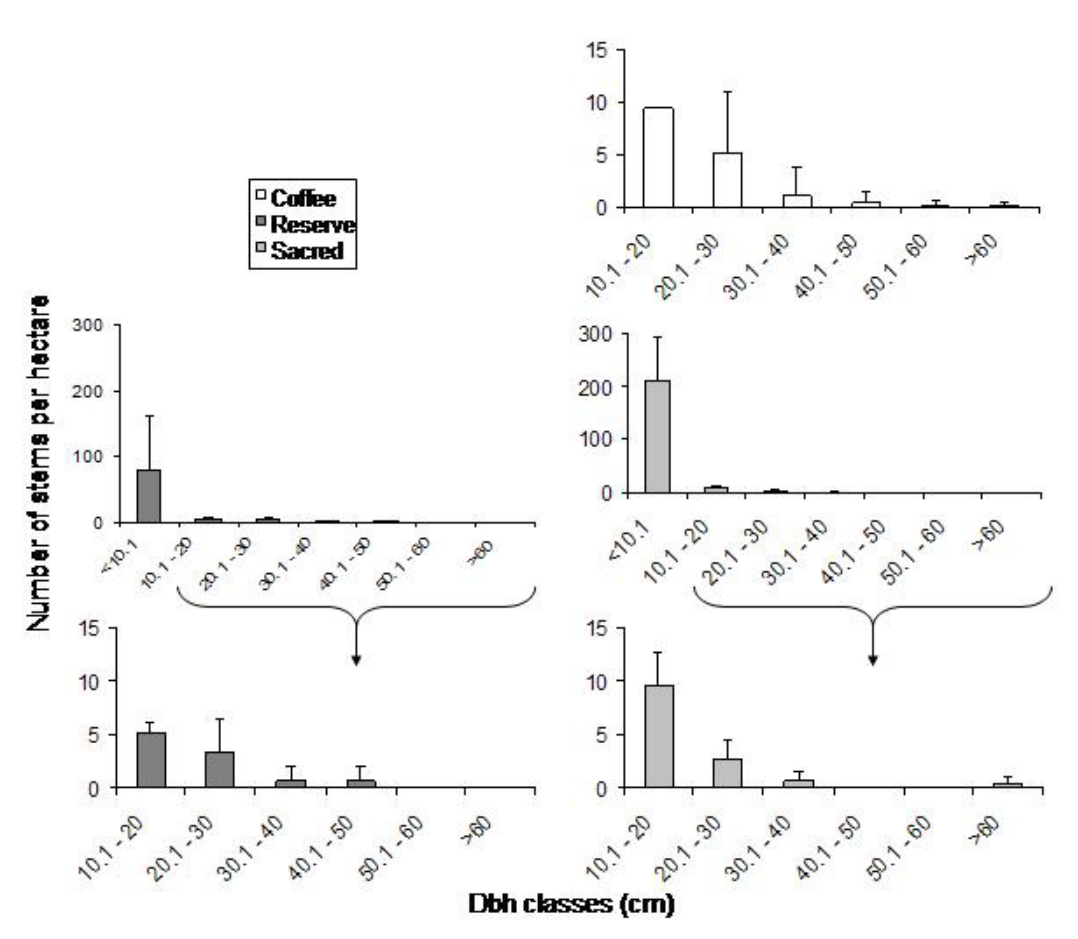
Fig. 6. Cinnamomum macrocarpum , which is medicinal and also yields other valuable non-timber forest products, regenerates better in sacred groves ( n = 19); the trees in the largest size classes are retained in coffee plantations ( n = 18), but are absent from the forest reserve ( n = 5) in Kodagu, Western Ghats of India. Note: error bars indicate 95% confidence